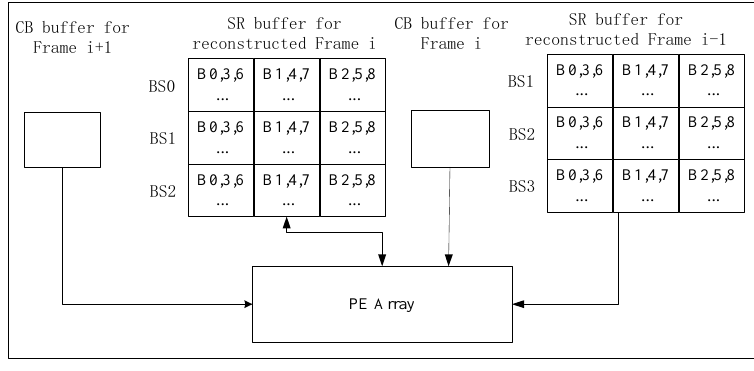
Figure 14. Architecture of Inter-C for VC-SRME. Two SR buffers are on chip. Data in SR Buffer for CB in Process Reconstructed Frame i